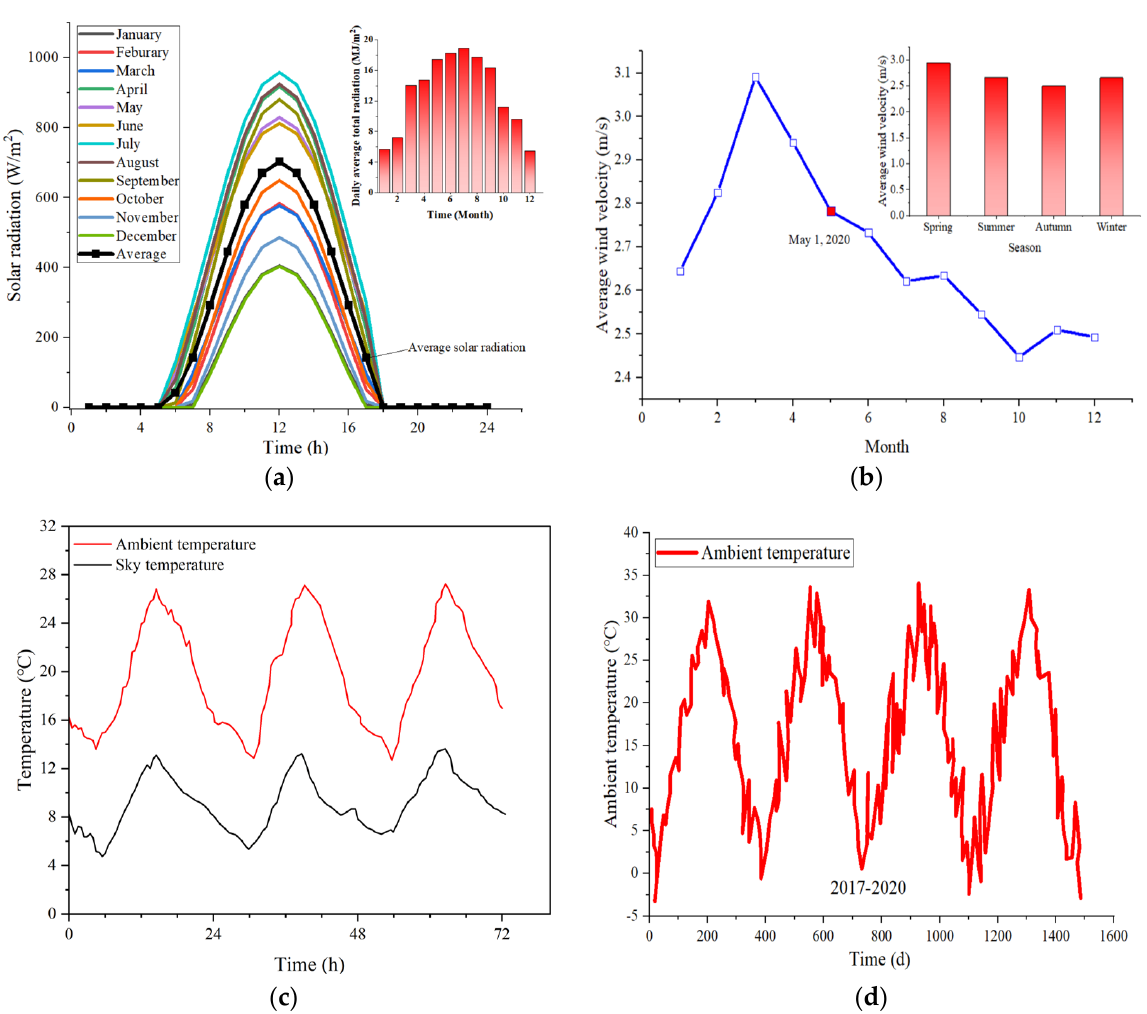
Figure 8. Measured environment parameters used for the numerical simulation. ( a ) Solar radiation (2020); ( b ) Wind velocity (2020); ( c ) Ambient temperature (1–3 May 2020); ( d ) Annual temperature curve (2017–2020).